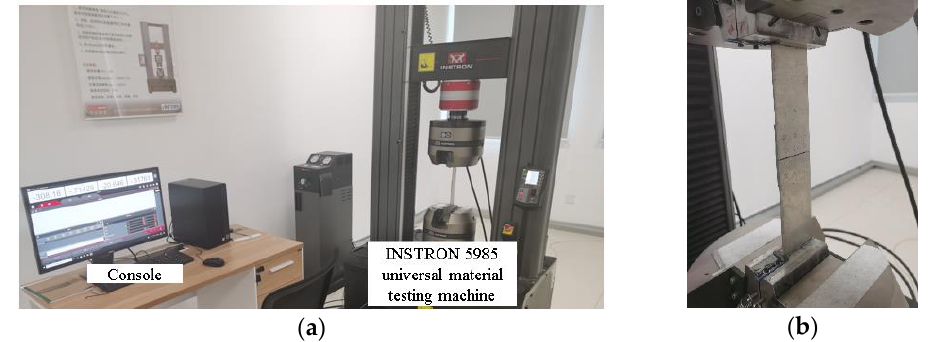
Figure 17. Static tensile test equipment and test scene: ( a ) INSTRON 5985 universal material testing machine; ( b ) schematic diagram of specimen clamping.